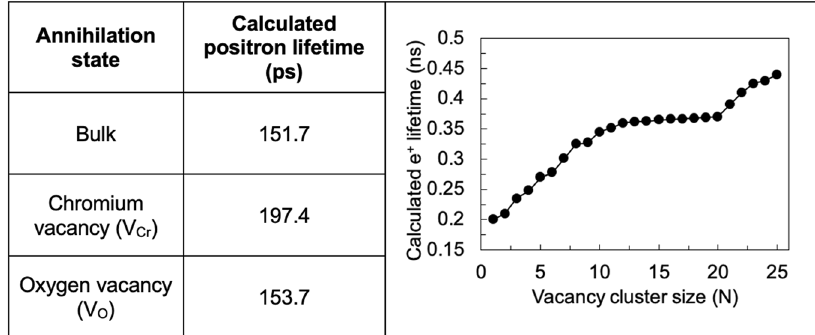
Fig. 7 ATSUP simulated annihilation states for bulk and monovacancy con fi gurations in Cr 2 O 3 . Calculated positron lifetime as a function of vacancy cluster size with N agglomerated vacancies is also plotted. The spherical void was obtained by removing Cr and O atoms around a reference point and sorted by